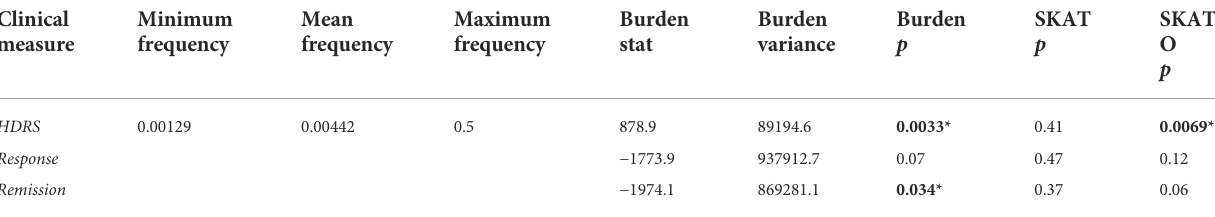
TABLE 3 SMMAT results. Data and results for variant set analyses of the association between rare (i.e., MAF < 5%) variants passing quality control and HDRSscores,responserates,andremissionrates.Allmodelsincludedage,sex,antidepressantclass,andvisitascovariables.Shownarethemean allelefrequency, theburden testscorestatisticandvariance,andthe associated p -valuesoftheburden, SKAT, andSKAT-O tests.boldtext*: p < 0.05. AF, allele frequency; p : p -value. Clinical measure